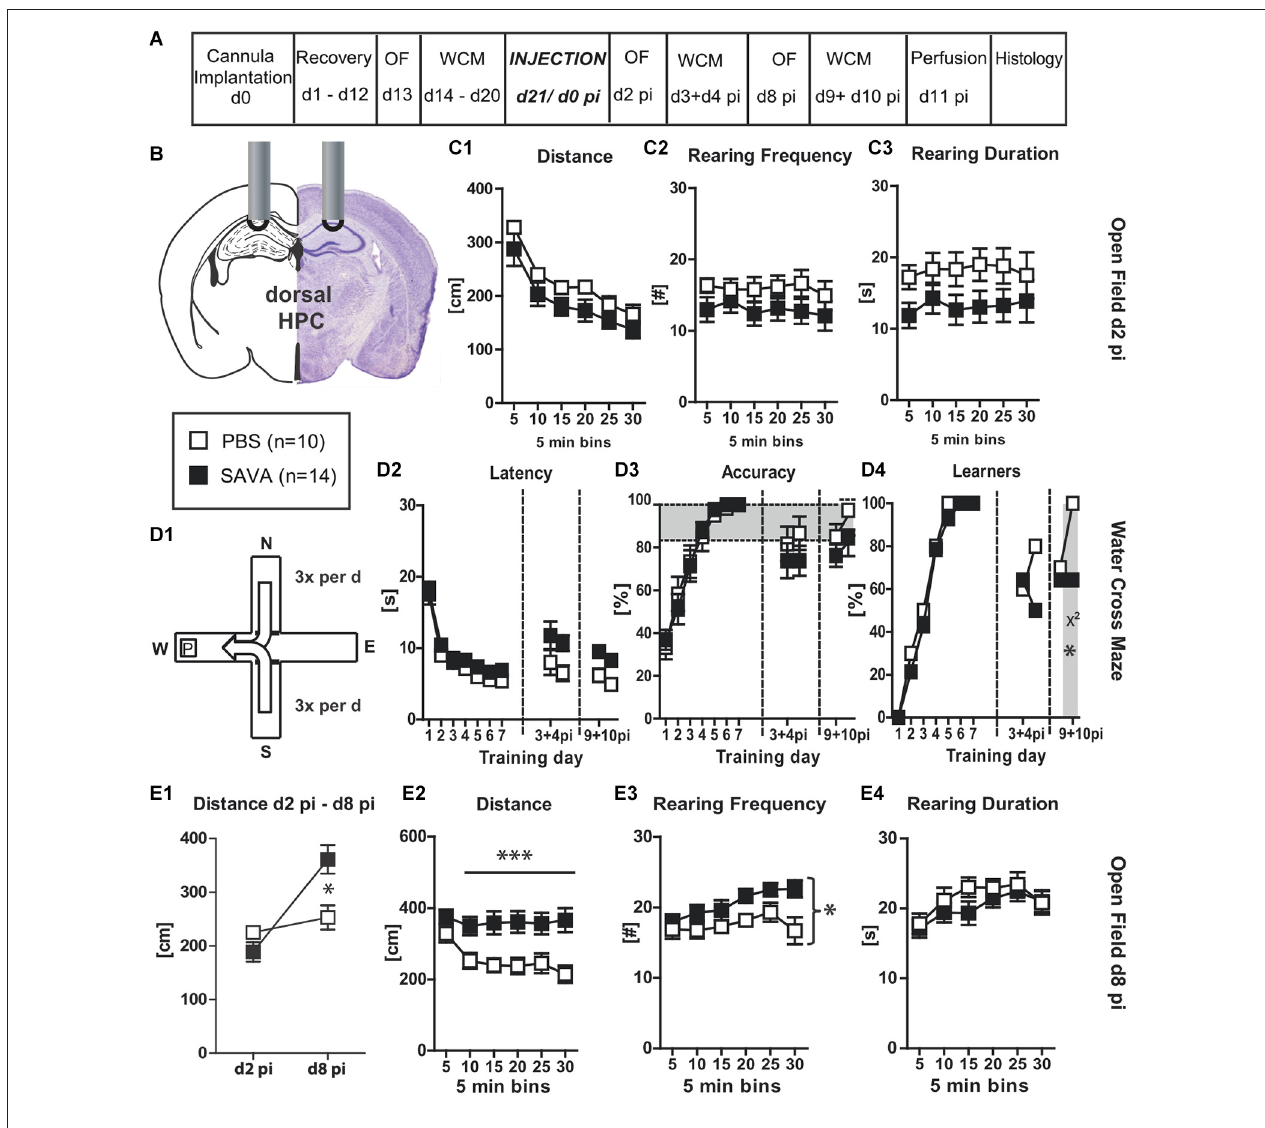
v 1.0 mm from Bregma; injection of 0.5 µ l PBS or SAVA per cannula; groups and sample size; (C1–3) OF behavior d2 pi; (D1) basic schema of WCM; (D2–4) learning parameters in the WCM; (E1) OF Distance d2 pi vs. d10 pi; (E2–4) OF behavior d8 pi All data presented as mean ± SEM; ∗ p < 0.05, ∗∗ p < 0.01, ∗∗∗ p < 0.001 (Student’s t -test, chi 2 test or ANOVA followed by Tukey post hoc test; abbreviations as in Figure 1